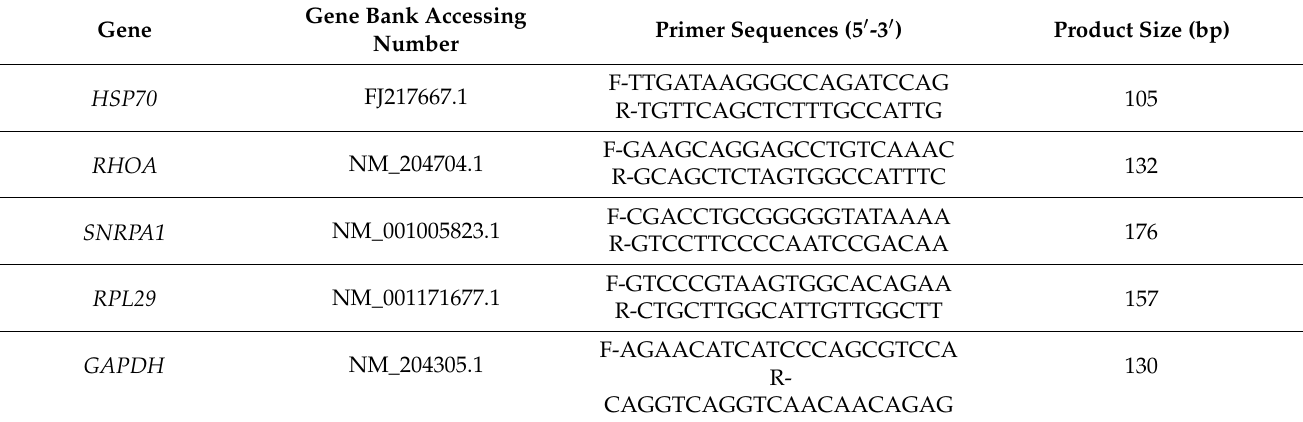
Table 1. Primer sequences used for qRT-PCR analysis of selected anti-freeze-associated